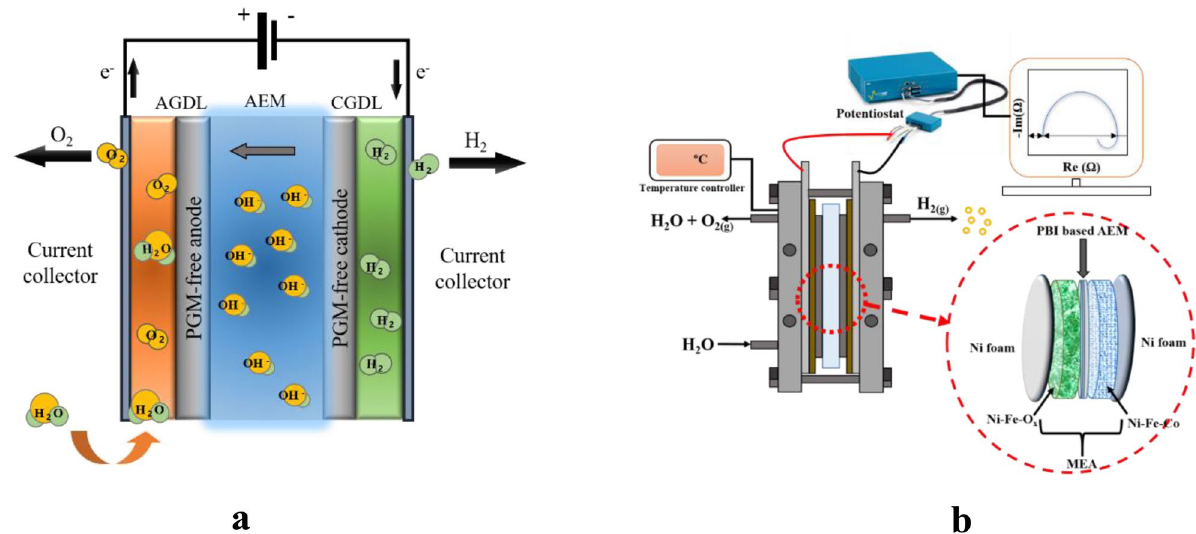
Figure 1. (a) Schematic of anion exchange membrane (AEM) electrolysis. AEM anion exchange membrane, AGDL anode gas diffusion layer, CGDL cathode gas diffusion layer. ( b) Schematic diagram of AEM water electrolysis with EIS experimental